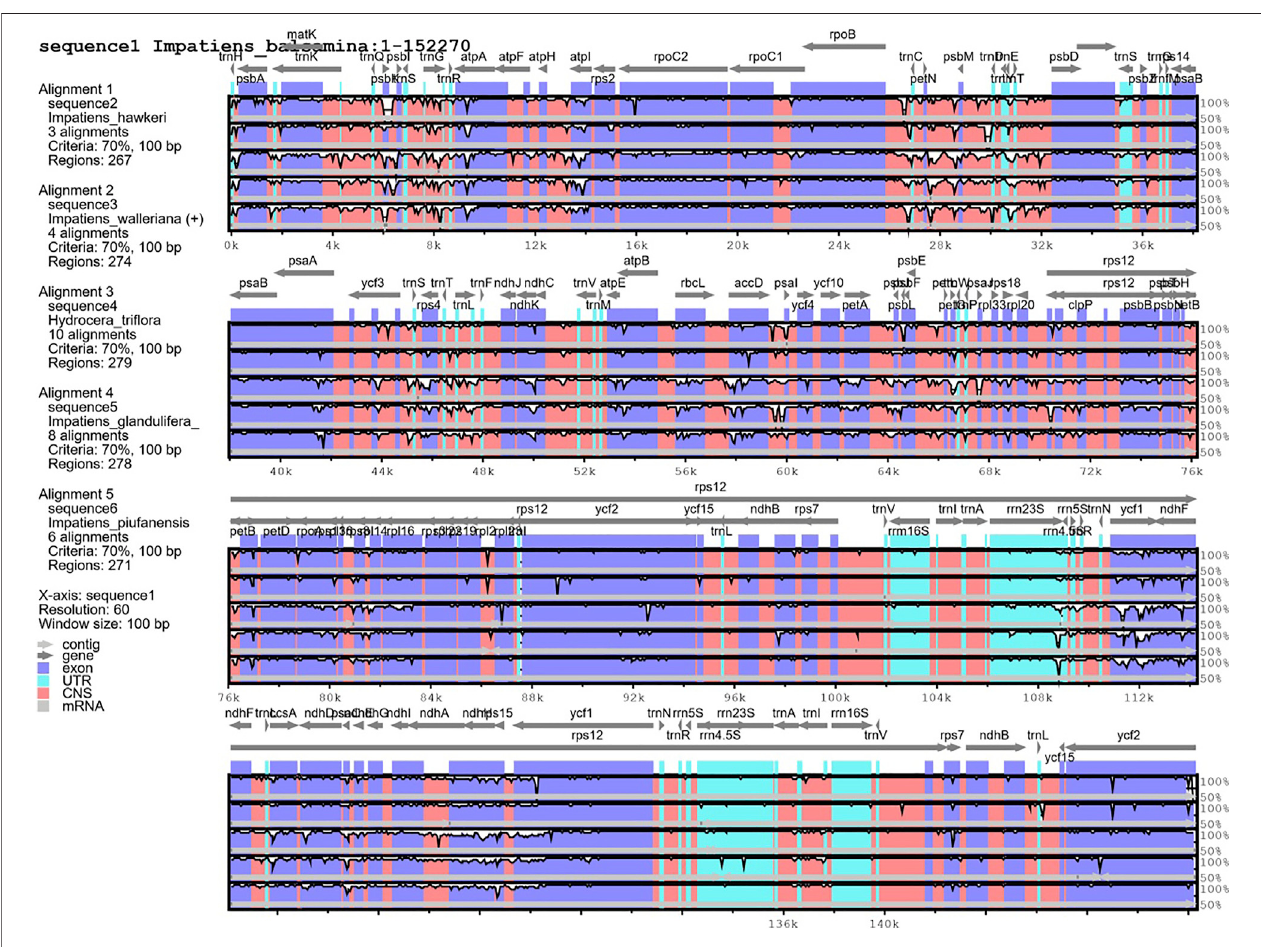
FIGURE 6 | Alignment of the six chloroplast genomes. Sequence identity plot comparing the fi ve chloroplast genomes with I. balsamina as a reference by using mVISTA.